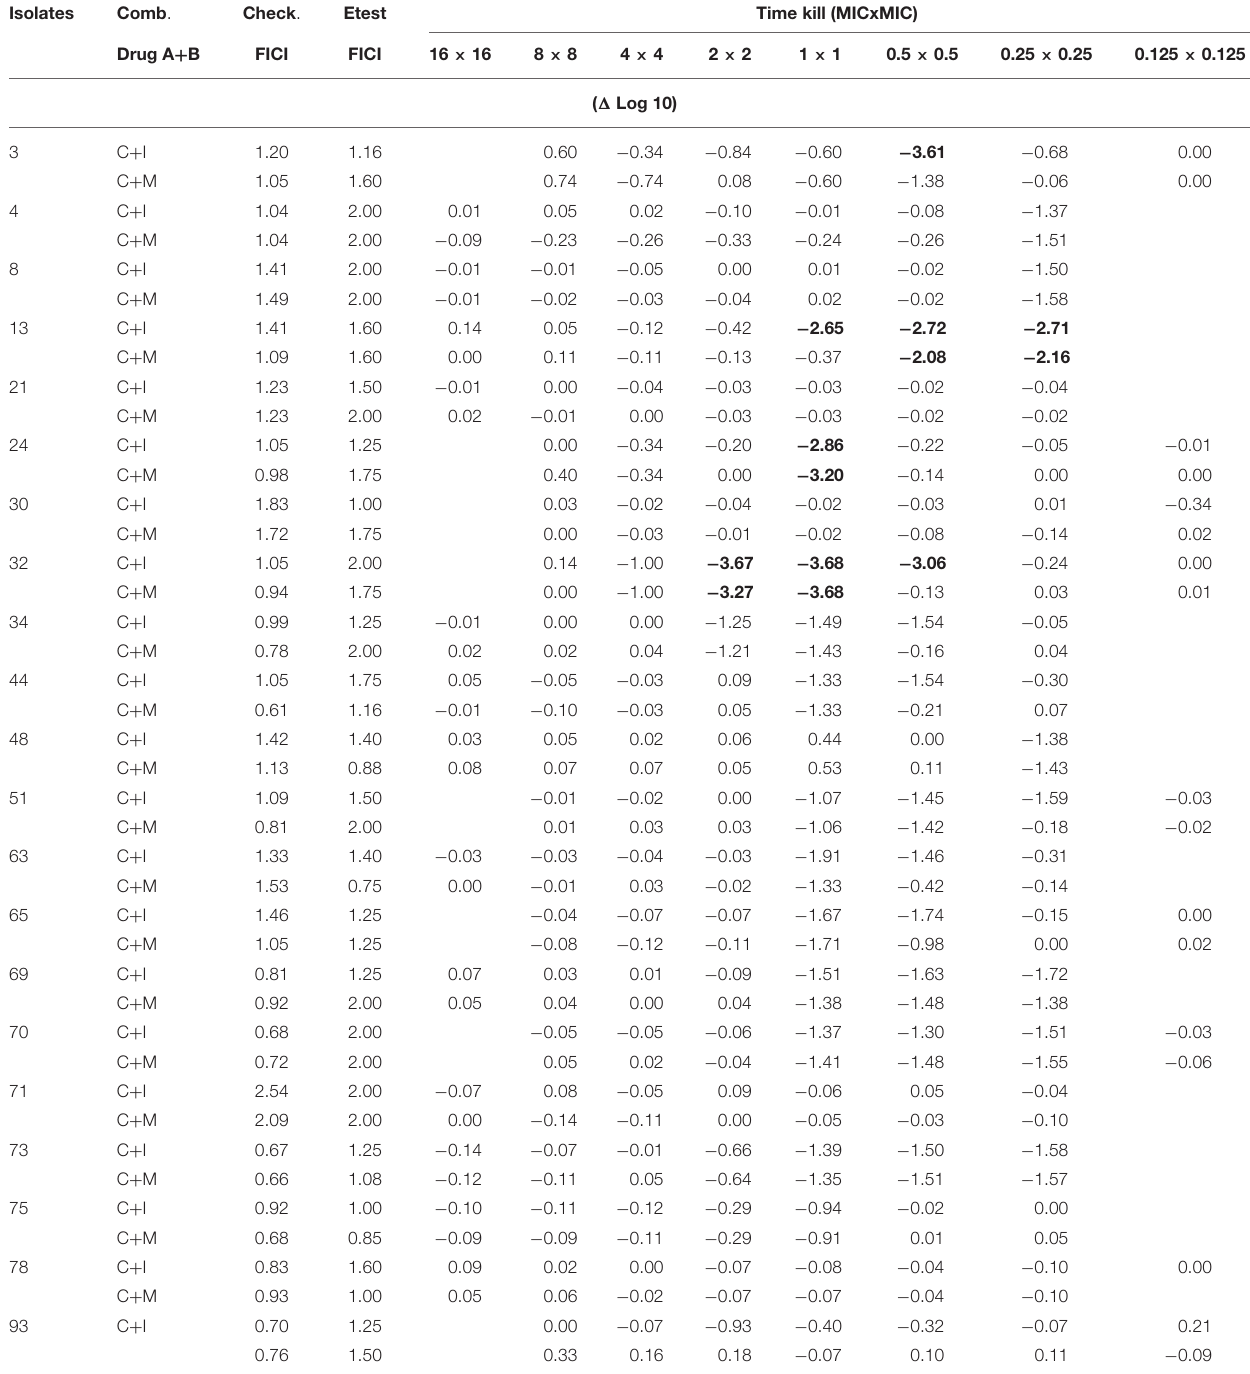
TABLE 6 | Comparative table of the three methods used. Isolates Comb . Check